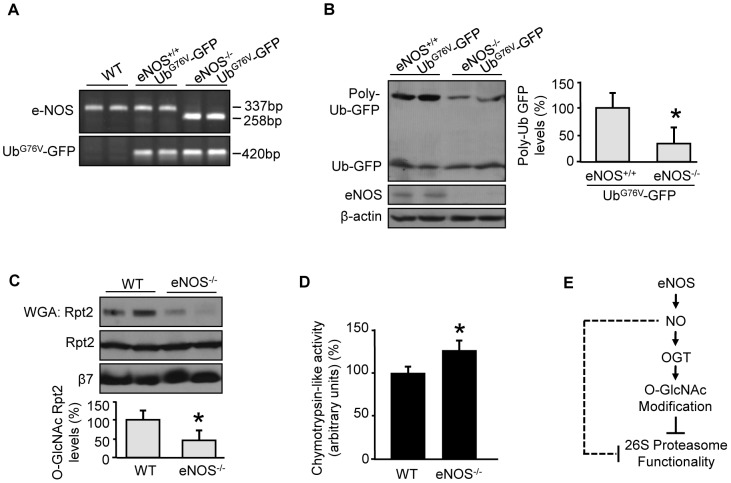
Loss of eNOS enhances 26S proteasome functionality which is associated with a reduction in Rpt2 O-GlcNAcylation and an increase in proteasome chymotrypsin-like activity.(A) Genotyping of wild type (C57BL/6J) mice, UbG76V-GFP (eNSO wild type) mice, and UbG76V-GFP mice lacking eNOS by PCR analysis. (B) Gender (male) and age (12 weeks) matched wild type mice, UbG76V-GFP/eNOS+/+ mice, and UbG76V-GFP/eNOS−/− mice (n = 5/group) were used. The 26S proteasome reporter protein poly-Ub-GFP was stained with a rabbit-derived anti-GFP antibody through Western blot. The eNOS protein of the aortic tissues was detectable in eNOS+/+ but not eNOS−/− mice. (C) Aortic tissues of the eNOS−/− vs WT mice exhibited a decrease in Rpt2 O-GlcNAcylation, without changing the protein levels total Rpt2 and β7. (D) The 26S proteasome activity (chymotrypsin-like activity) was significantly higher in eNOS−/− vs WT mouse aortic tissues. (E) Proposed mechanisms of 26S proteasome regulation by eNOS-derived NO in vascular endothelial cells. In vascular endothelial cells, the eNOS-derived NO, which has been known to be expressed constitutively at low basal levels, maintains basal functionality of the 26S proteasome. This was achieved through an OGT-dependent O-GlcNAc modification of proteasome, likely on Rpt2, a key subunit of the proteasome regulatory complex recognized for this type of modification and associated with 26S proteasome function. The supporting evidence was obtained through either genetic or pharmacologic approaches both in 26S proteasome reporter cell and mouse models. eNOS, endothelial nitric oxide synthase; OGT, O-GlcNAc transferase; SNP, sodium nitroprusside; WGA, wheat germ agglutinin; WT, wild type.